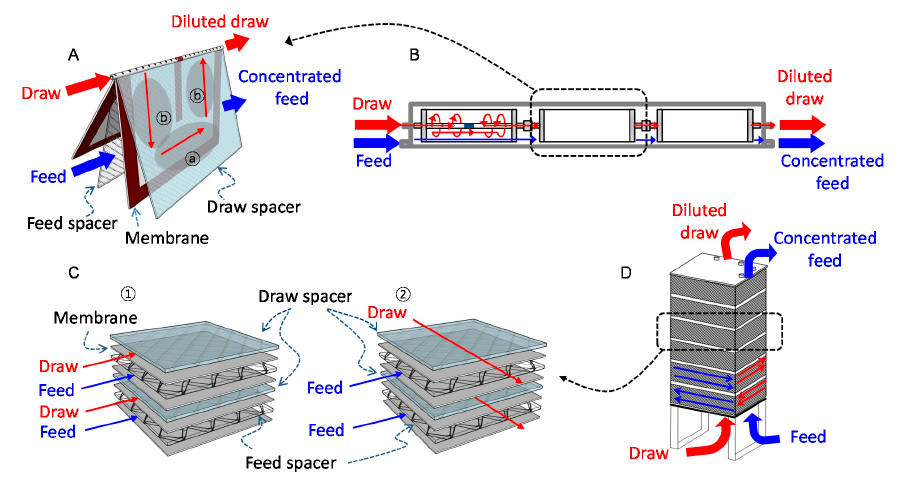
Figure 1. Schematic diagram of the spiral-wound (SW) and plate-and-frame (PF) forward osmoses (FO) module. ( A ) Flow directions of draw solution and feed solution in the SW FO element, ( B ) SW FO module comprising elements connected in series inside a vessel, ( C ) ① : Co-current flow in ⓐ the zone of SW FO element, ② : Cross-current flow in PF FO and ⓑ zone of SW FO elements, ( D ) PF FO module comprising stacked elements connected in series.